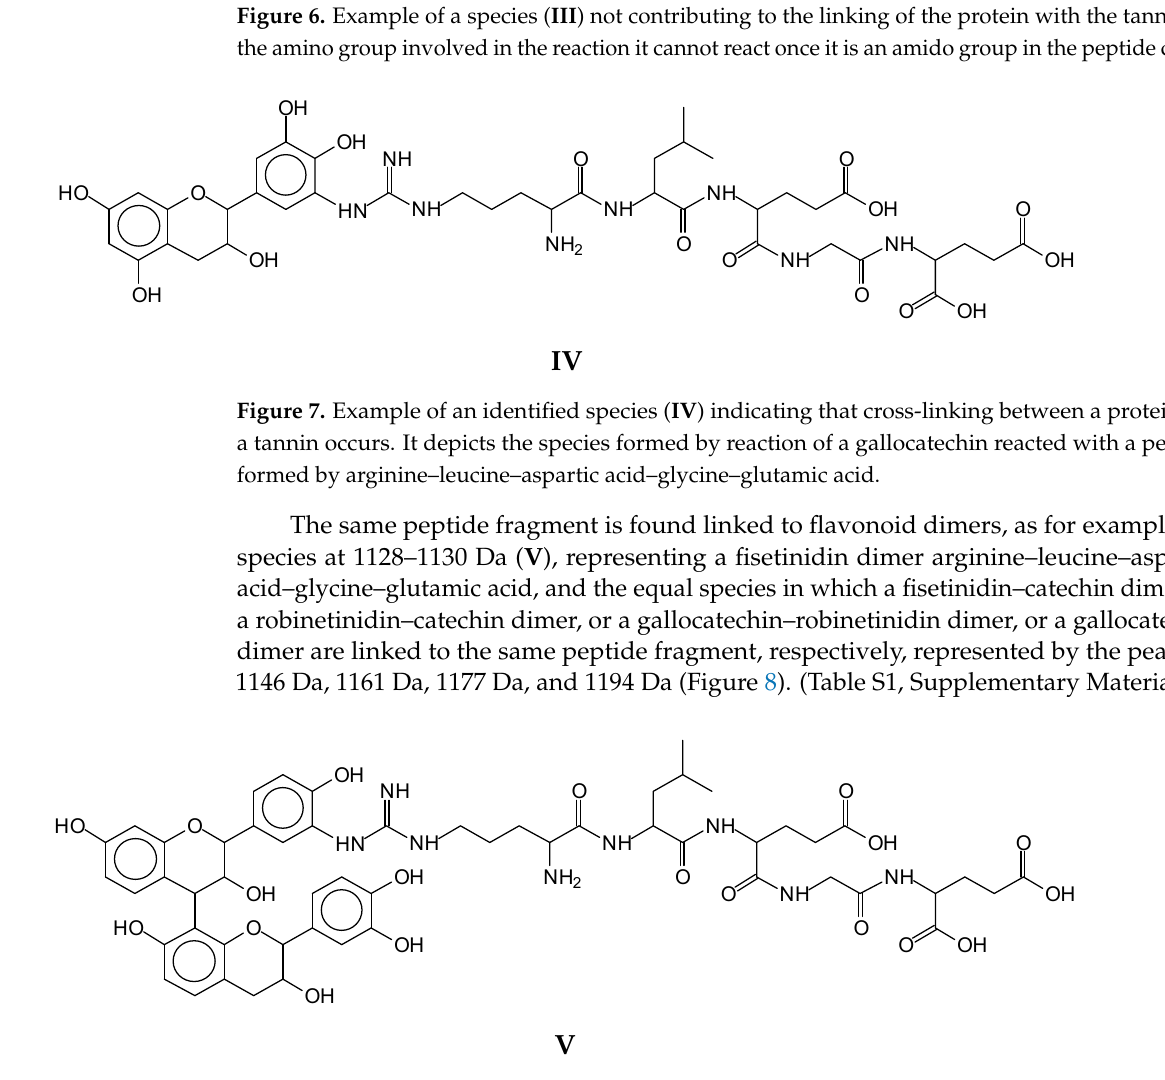
VI Figure 9 . Example of a species ( VI ) of the same molecular weight of species V in which the peptide chain oligomer is linked to two flavonoid monomer units of tannin oligomers, showing the possibilities of cross-linking of the adhesive system. The presence of structures of the same nature as structures V and VI , and even of higher molecular weight (Table S1, Supplementary Material) indicates that peptide se- quences are linked to tannin oligomers, and that peptide sequences can form bridges be- tween flavonoid units, either alone or in flavonoid tannin oligomers. It is equally evident that while at ambient temperature ionic bonds are found [23,24], at 80 °C instead no ionic bond linked products are formed, the totality of the reaction products being covalently bound, meaning that the material starts to be quite advanced in cross-linking, confirming the plywood shear strength results in Figure 1. 4. Conclusions The title of this paper is “a study of concept…” because what disclosed and found in the work presented here does not pretend to be only applicable by itself and not even to be the final word on soy or protein wood adhesives and on wood adhesives from totally bio-sourced natural materials of vegetable origin. It is presented with the clear intention